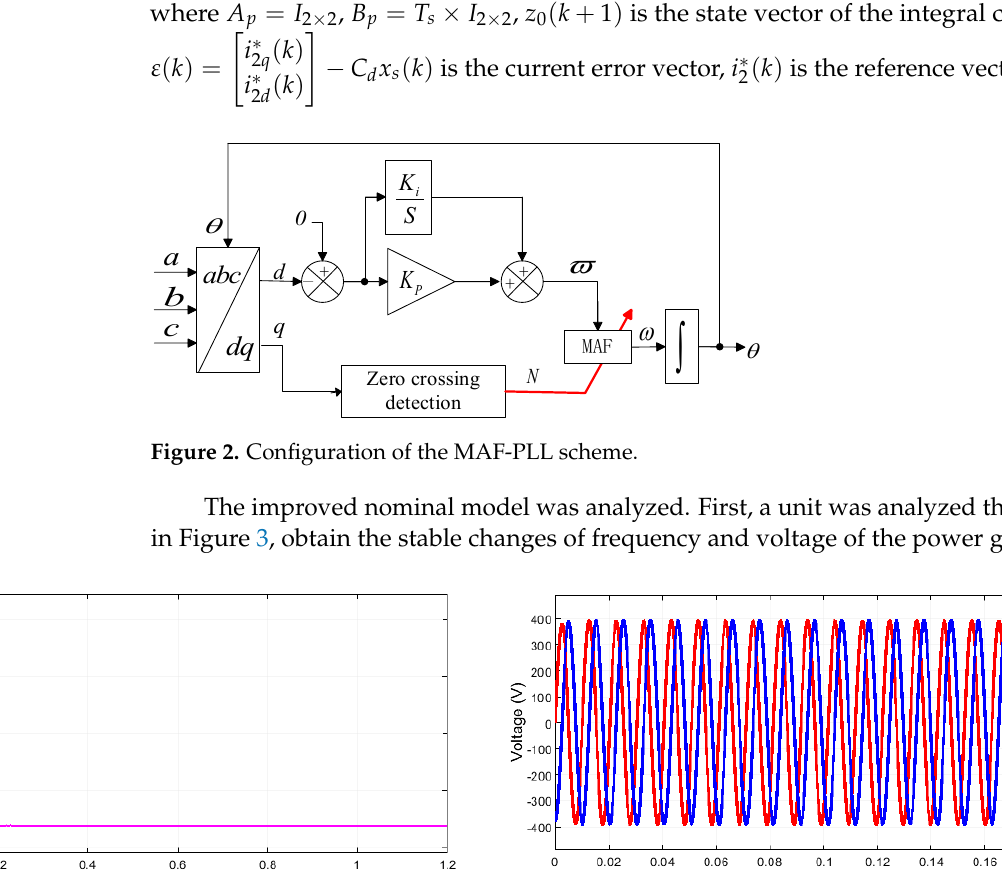
Table 1. System Table 1. System parameters.